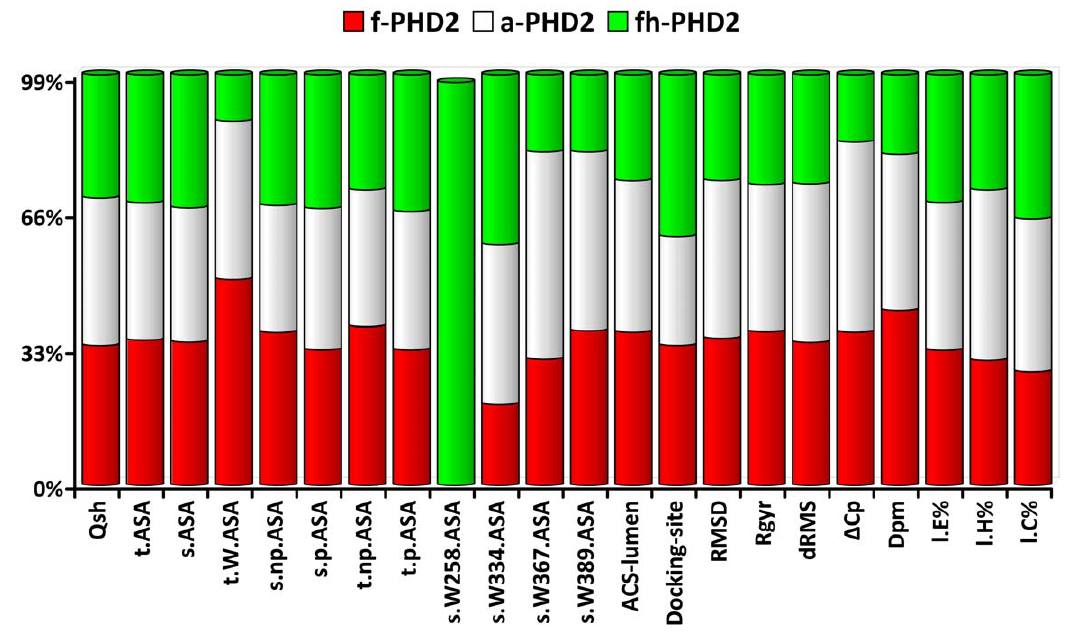
Figure 5. Comparing the percentage of PHD2 species contribution to each variable during partial unfolding. The contribution of PHD2 species to each property’s information content is represented in percent. p, np note polar or non-polar parts of the molecule. ASA stands for accessible surface area, t and s stand for total and side chain respectively. Rgyr stands for radius of gyration. Dpm notes the dipole moment. W stands for tryptophan residue. Docking site and active site lumen are the ASA of corresponding parts of PHD2. l.E% and l.H% stand for the amount of strand or helix structure melting respectively. l.C% notes the amount of appeared coiled structure.